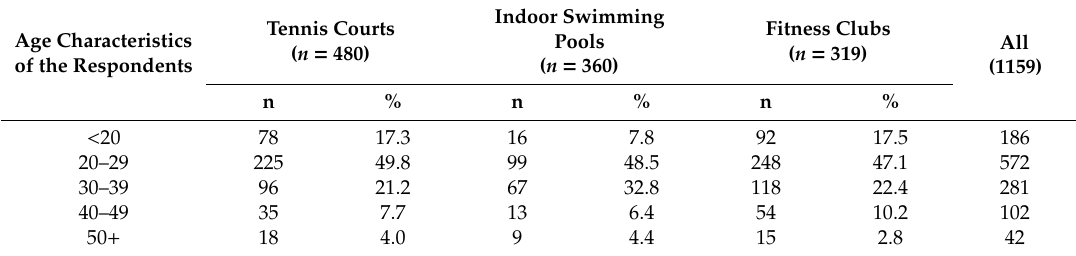
Table 2. Characteristics of